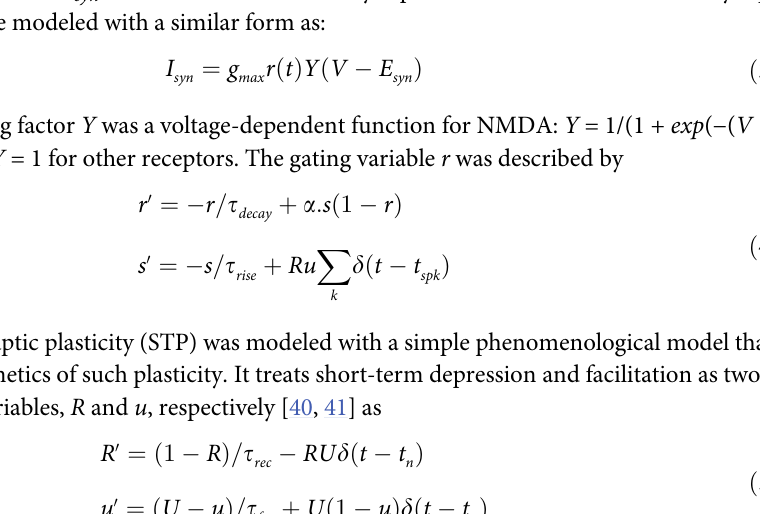
For synaptic currents, the I of GCs represents the excitatory input from MFs and inhibition syn input from GoCs. The I of GoCs receives excitatory input from GCs and MFs. All the synap- syn tic currents were modeled with a similar form as: